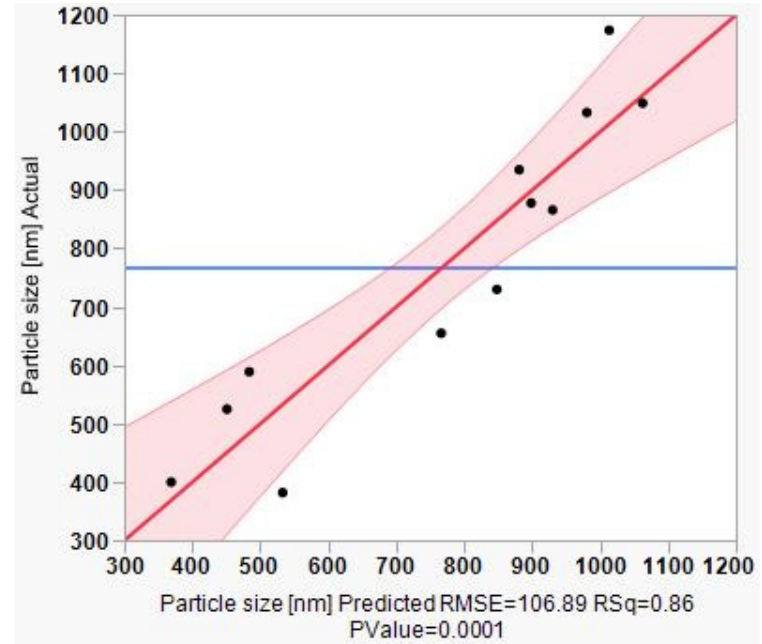
Figure 6. Leverage plot for the whole model of actual vs. predicted particle size.